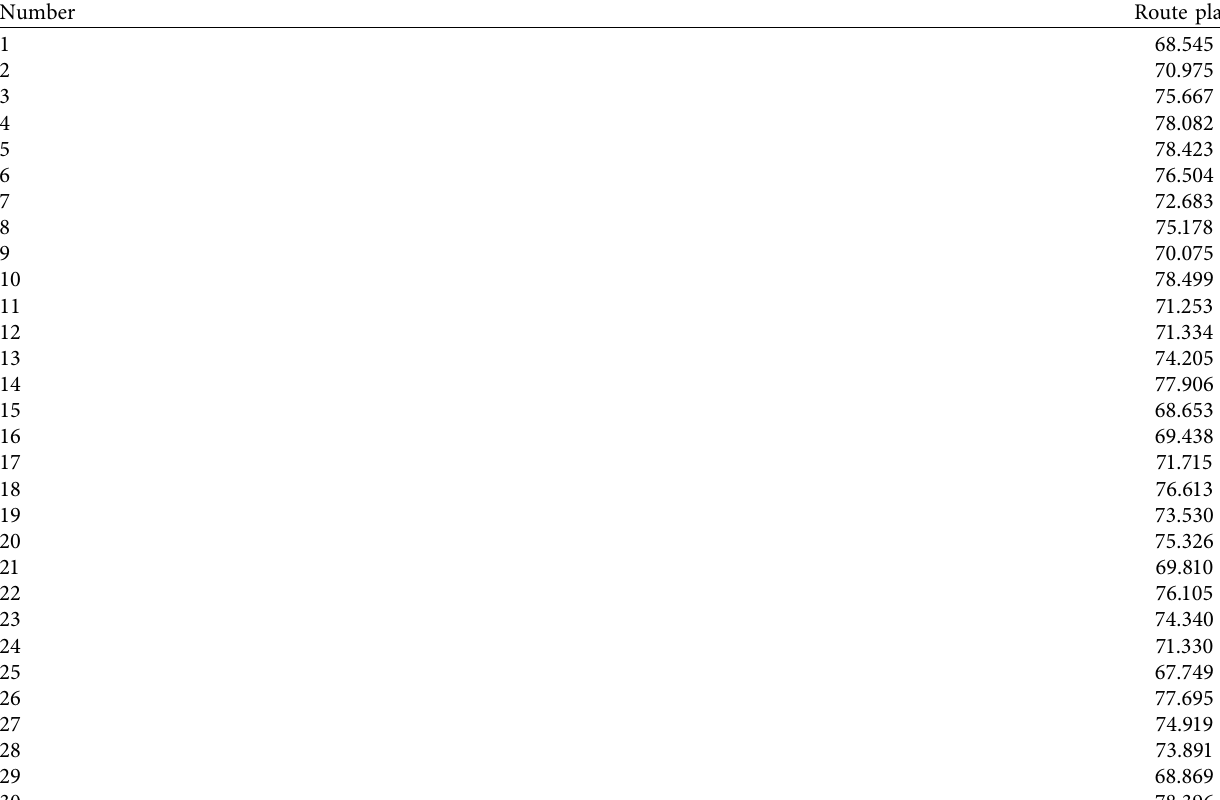
Table 1: Te route planning efect of the robot based on deep